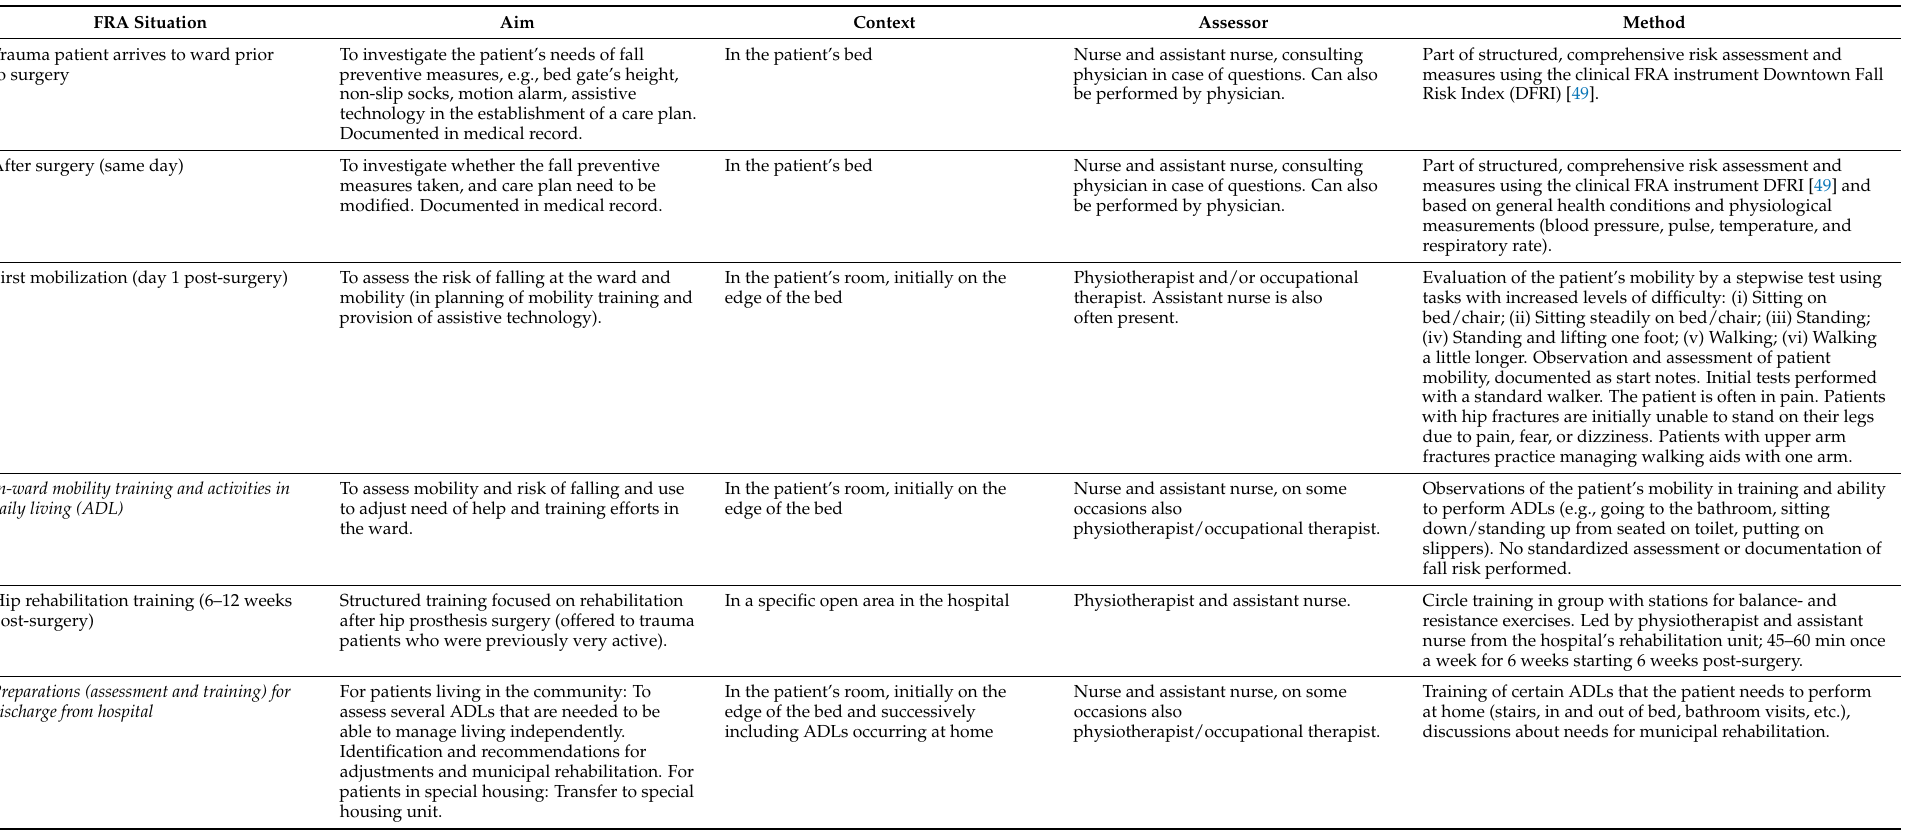
Table 1. Clinical FRA situations identified in a focus group interview with clinical staff. The selected FRA situations to explore further regarding SFRA are highlighted in